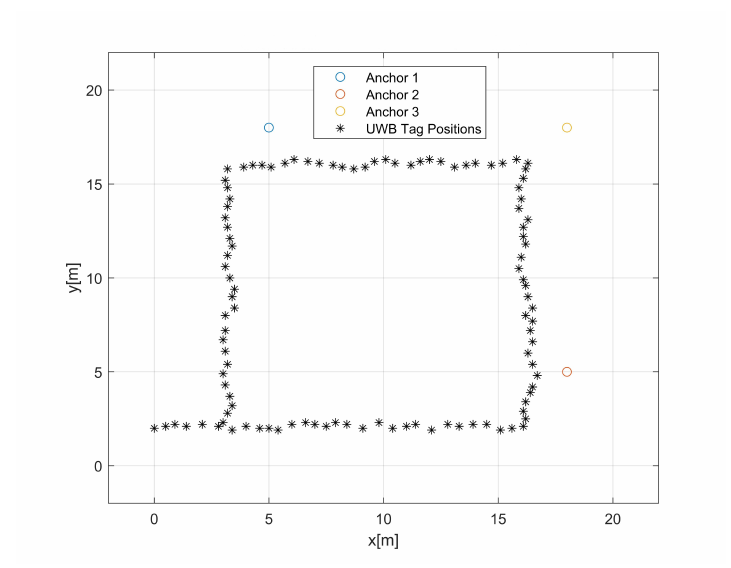
Figure 9. UWB anchors & tag